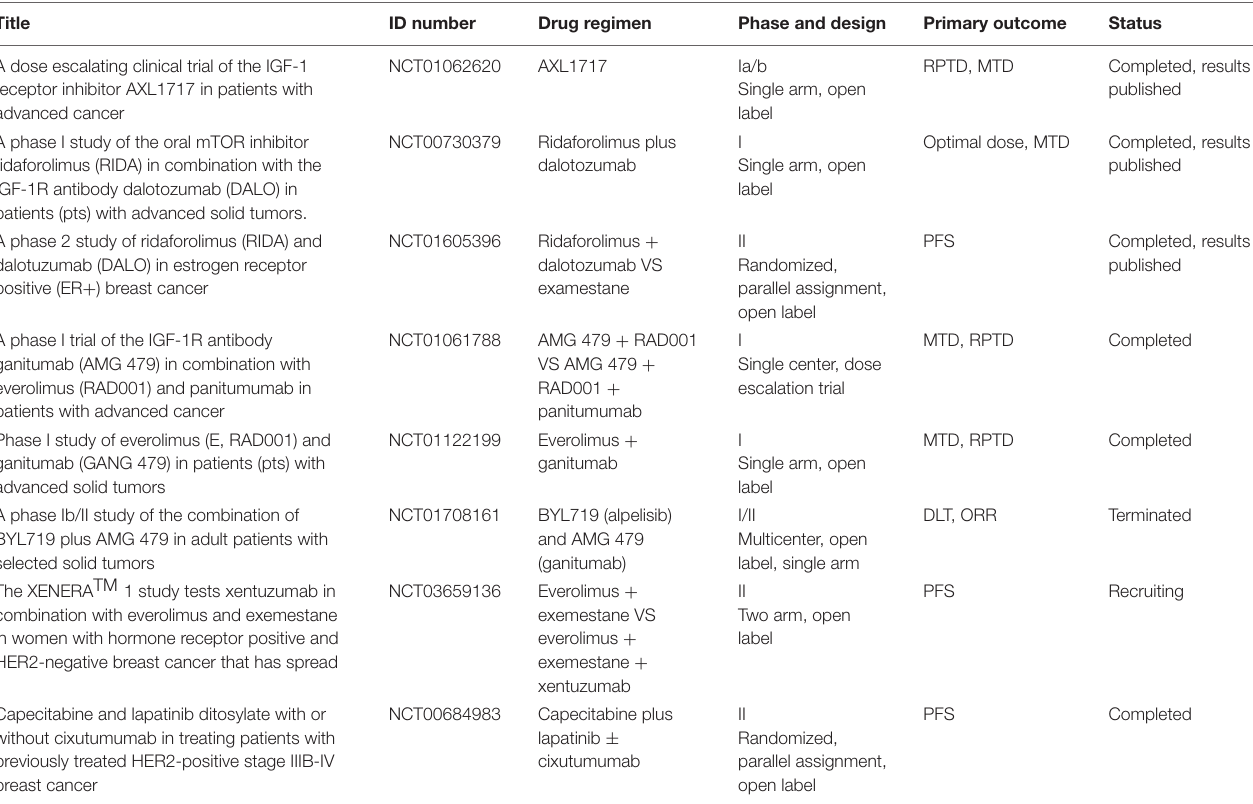
TABLE 1 | Key clinical trial targeting IGF-1 axis in solid